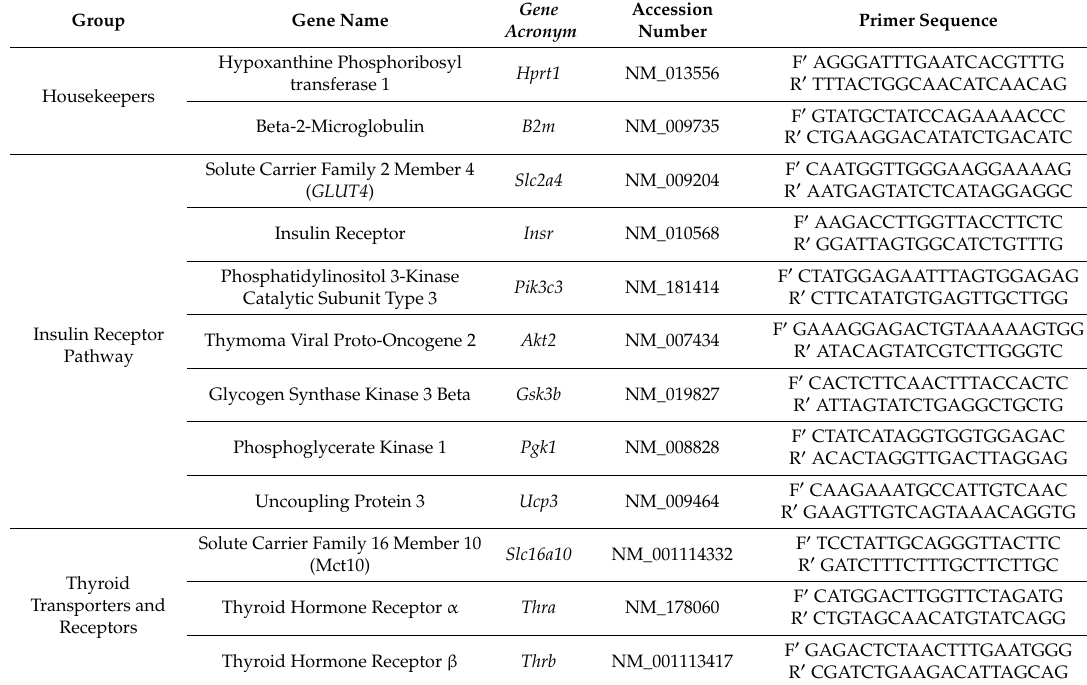
Table 1. qPCR primer